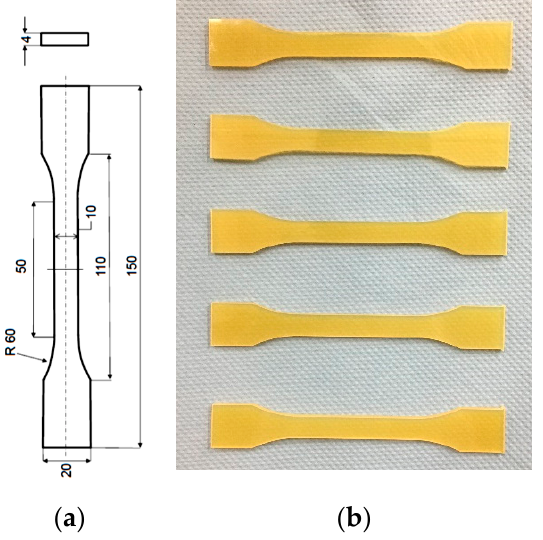
Figure 4. ( a ) EN ISO 527-2 type 1B geometry for the tensile test specimens. All dimensions are in mm. ( b ) Photograph of epoxy-based dog-bone specimens used for tensile testing.